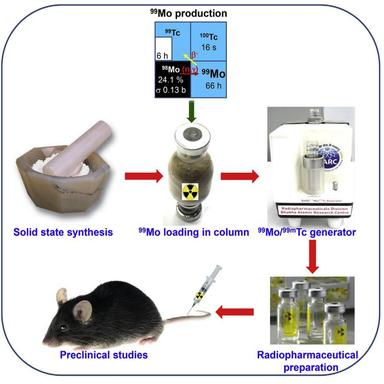
Schematic diagram illustrating solid state synthesis of mesoporous alumina for preparation of 99Mo/99mTc generator using 99Mo produced by direct 98Mo (n, γ) 99Mo reaction. The 99Mo/99mTc generator was utilized for obtaining 99mTc suitable for preparation of target specific radiopharmaceutical, the efficacy of which was established by preclinical studies in animal models.